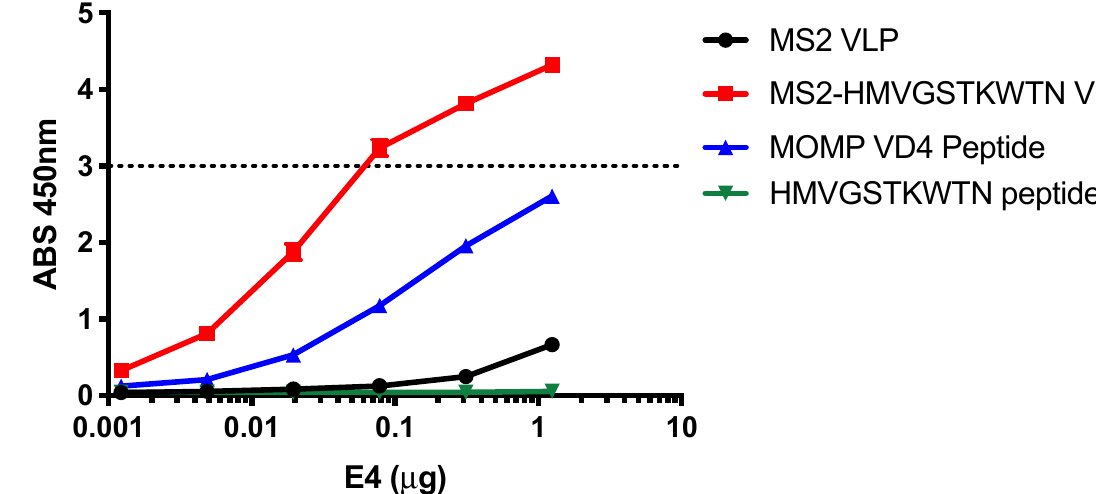
Figure 2. E4 mAb binds to HMVGSTKWTN peptide in a conformation-dependent manner. E4 mAb binding to linear HMVGSTKWTN peptide, MS2-HMVGSTKWTN (MS2 VLP displaying HMVGSTKWTN in the AB loop), MS2 VLP (negative control), and VD4 epitope linear peptide (FDTTTLNPTIAGAGDVK) was assessed by ELISA at various concentrations of E4 mAb. Data are the average of three technical replicates. The dashed line represents the linear limit of the ELISA plate